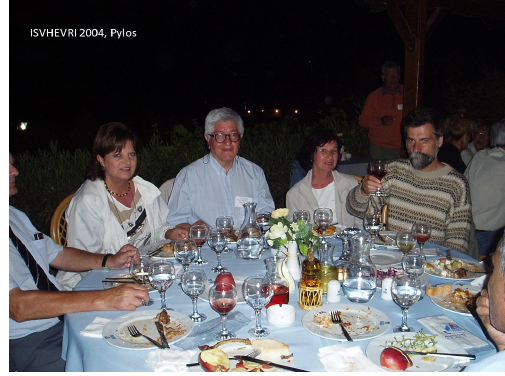
Figure 1. Last participation at the 19 th ISVECRI-2016, Moscow. Figure 2. 13 th ISVHECRI-2004,